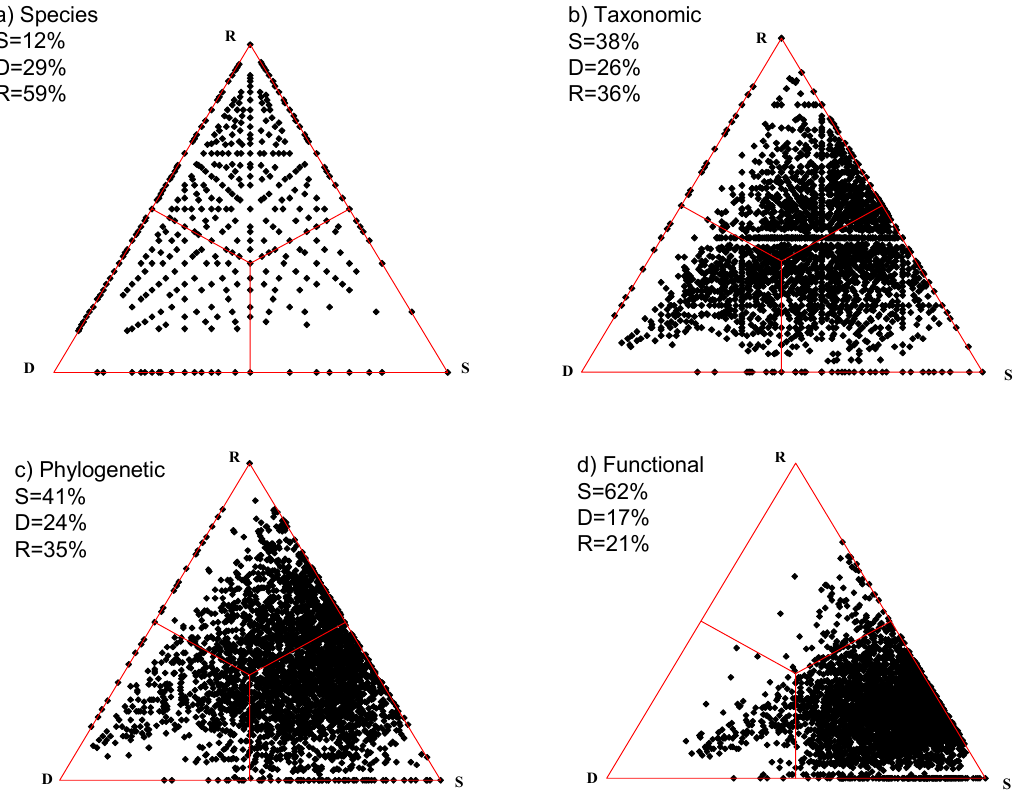
Figure 4. Four simplex diagrams for the salt marsh data. Percentage scores refer to the respective centroids multiplied by 100. ( a ) Species; ( b ) Taxonomic; ( c ) Phylogenetic; ( d ) Functional.